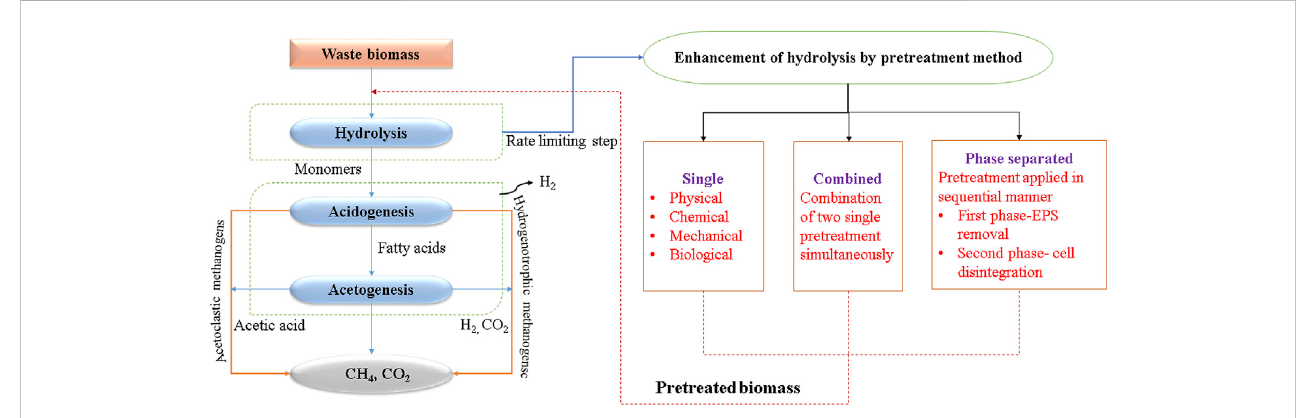
FIGURE 3 Pretreatment techniques for enhanced enzymatic hydrolysis during anaerobic